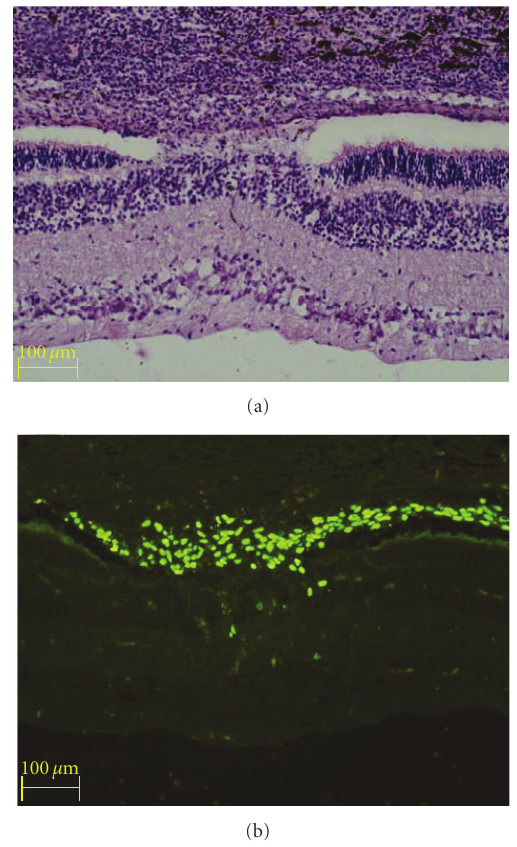
Figure 5: Evaluation of host tissue and cellular response in the area of laser burn. A subset of sections from eyes with xenografts were stained with H&E (a) to evaluate the host tissue and cellular responses, while adjacent sections were immunolabeled to identify human donor cells (b). (a) The area of laser injury can be identified by the focal disturbance of the overlying pigmented layers, as well as localized disruption of the underlying retina. An abnormal adhesion between the retina and overlying structures is present in this locationthat bridges the subretinal space. A dense mononuclear infiltrate is present in the choroid (top), consistent with the development of a strong immune response. (b) Immunoimaging reveals the presence of many donor cells, which have preferentially congregated in the area of laser injury and appear to contribute to the subretinal adhesion. A few donor profiles are present in the neural retina in the immediate vicinity of the laser injury. Survival = 10